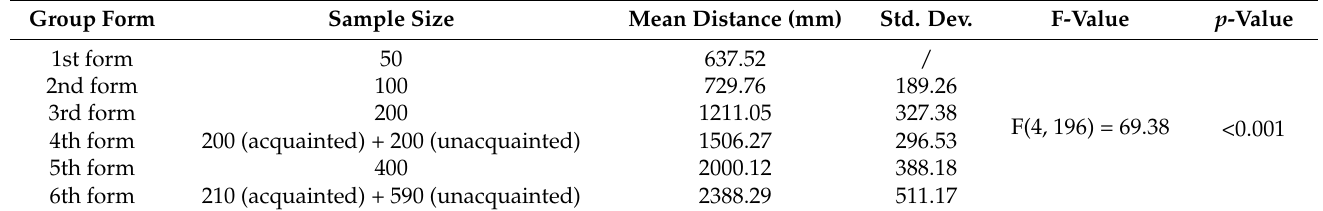
Table 2. Group size effect on the participants’ spatial distance toward the large display.